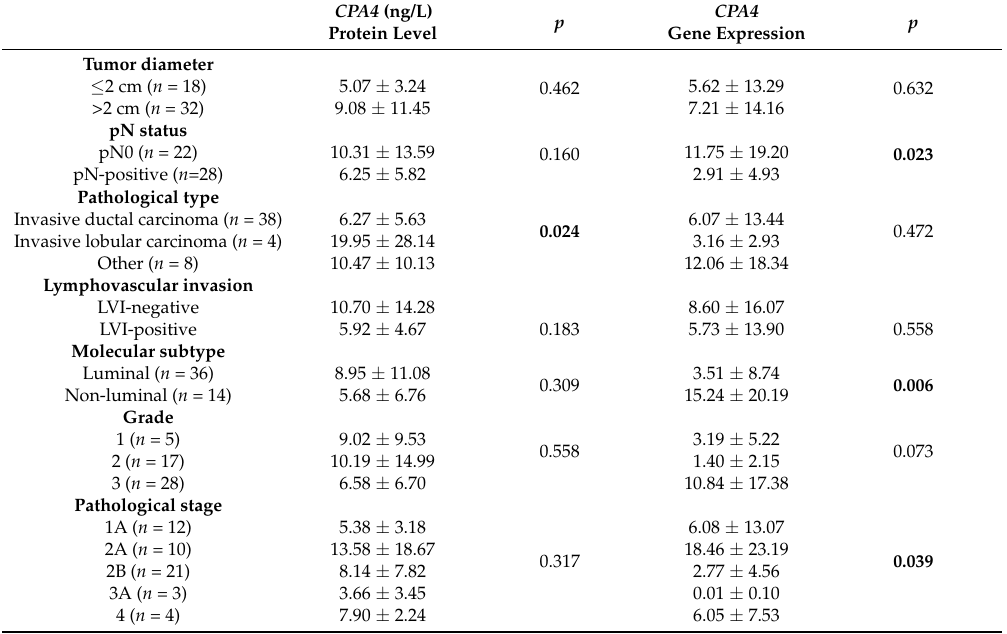
Table 3. The patients’ serum CPA4 and CPA4 mRNA levels as analyzed based on subgrouping by tumor